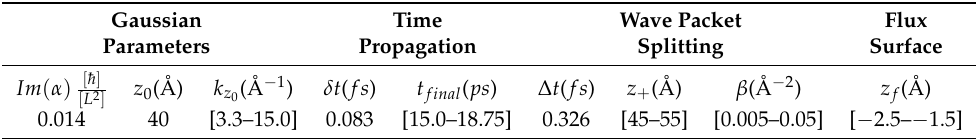
Table A2. Parameters of the wave packet propagation, [: - :] indicates the range of values taken in different calculations (definitions specified in the